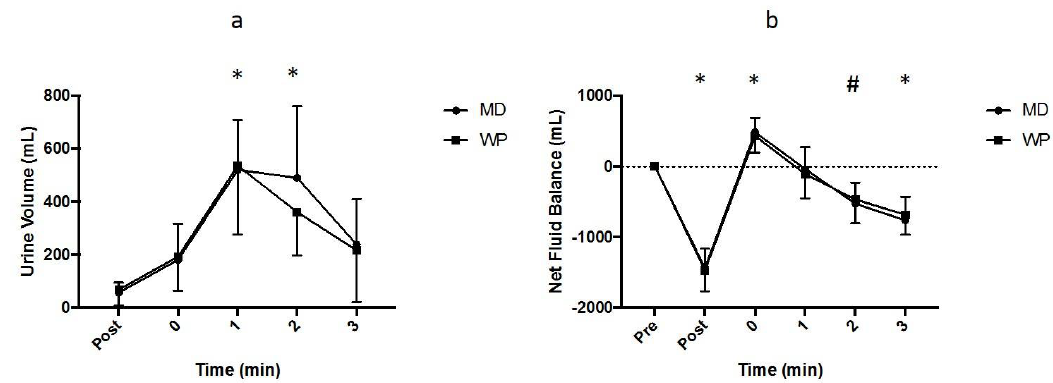
Figure 3. ( a ) Urine volume (mL) produced at each time point during the maltodextrin (MD) and whey protein (WP) trials. “*” indicates a significantly different time point ( p < 0.050) from post-exercise